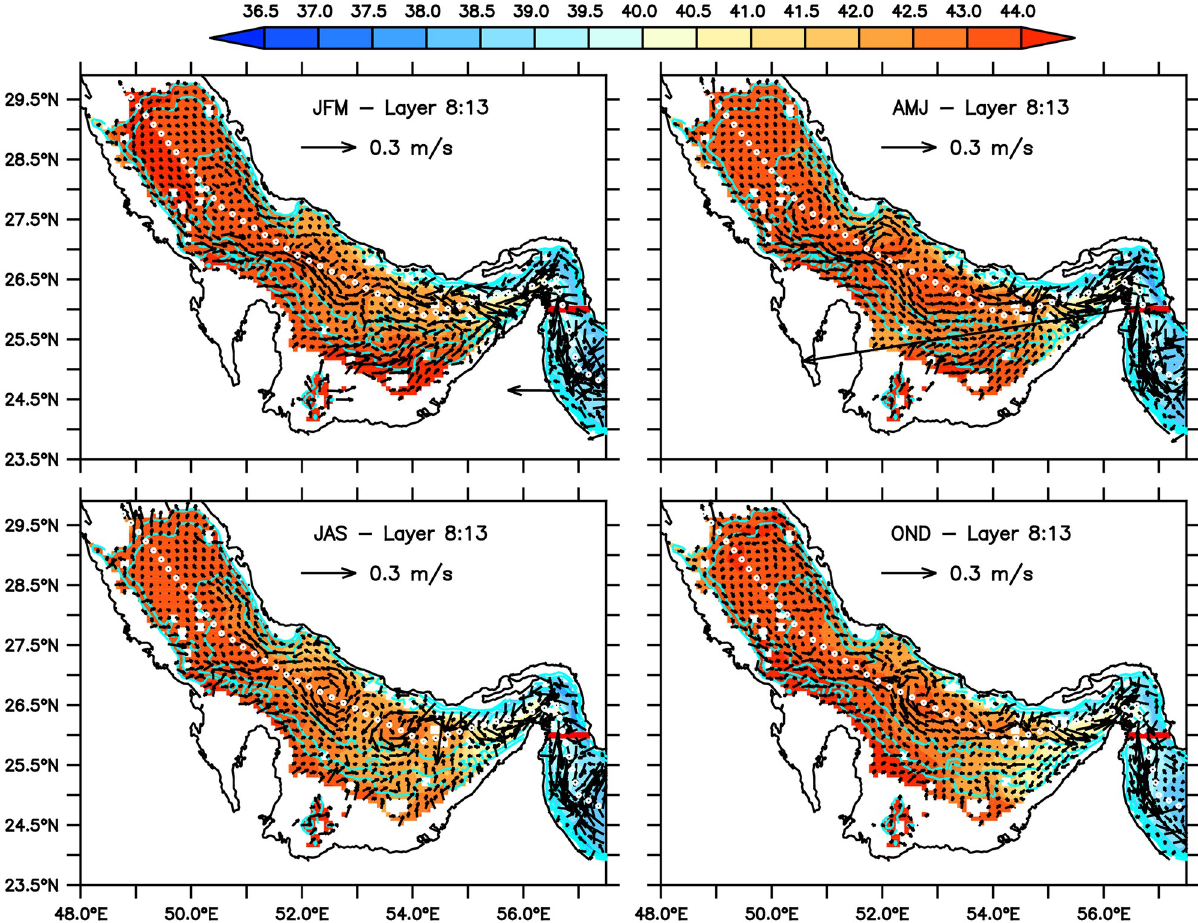
Fig 4. Seasonal mean distributions of salinity and velocity averaged from the 8th to 13th seven layers representing the circulation and salinity in the “bottom layer”, with a mean thickness of about 20m (see Fig 5).